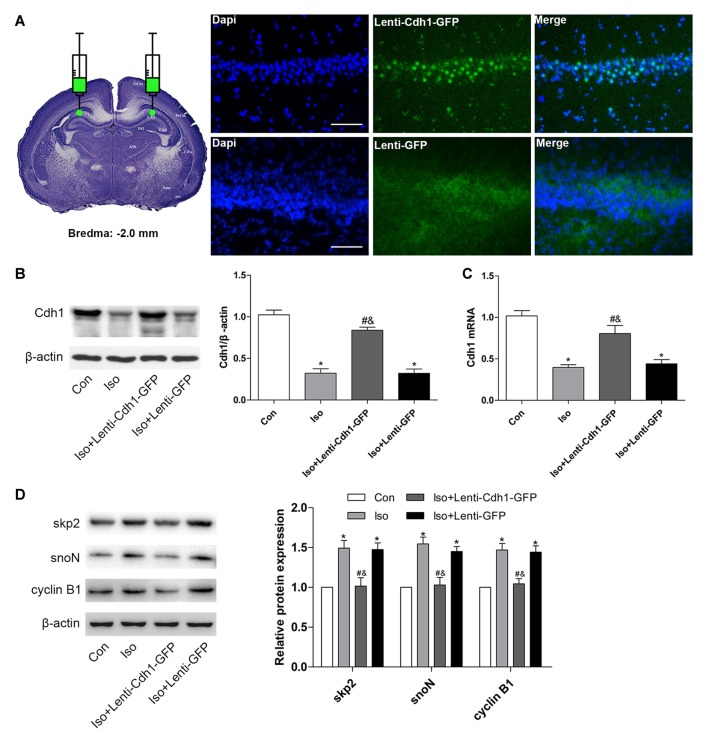
Cdh1 overexpression in the hippocampus in developing rats after bilateral intra-hippocampal injection with Cdh1-encoding lentivirus. Cdh1-expressing lentivirus (in the Iso + Lenti-Cdh1-GFP group) and control lentivirus (in the Iso + Lenti-GFP group) were injected into the bilateral hippocampus of rat pups at P3 before isoflurane inhalation on P7. (A) The picture demonstrates that intra-hippocampal injection of the lentivirus was administered according to the coordinates: the Bregma as zero; anterior, −2.0 mm; lateral, ±1.6 mm; dorsal, −2.5 mm. GFP-positive signals were mainly detected in the hippocampus and surrounding area after 3 days. (B) Western blotting was used to evaluate the expression of Cdh1 in the control and isoflurane-treatment groups (lanes 2–4). The histogram represents the relative levels of Cdh1 (n = 3 in each group). (C) The histogram shows the mRNA expression of Cdh1 after lentivirus-pretreatment and isoflurane-treatment by real-time PCR (n = 3 in each group). (D) The expression of Cdh1 substrates (skp2, snoN and cyclin B1) were analyzed by western blotting (n = 3 in each group). Values are presented as mean ± SEM. *P < 0.05 vs. control group, #P < 0.05 vs. Iso group, &P < 0.05 vs. Iso + Lenti-GFP group.